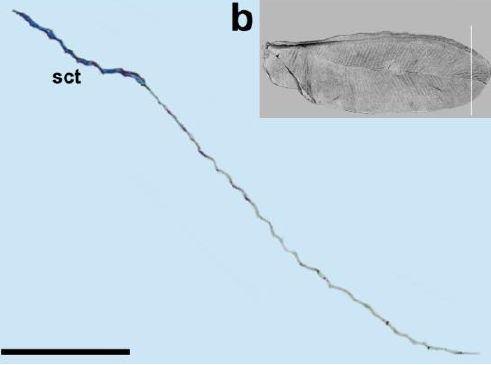
Figure 6. Cross-section of the wing of M. pini . Scale bar 100 µ m; ( a , b ) median fold in black dotted circle.